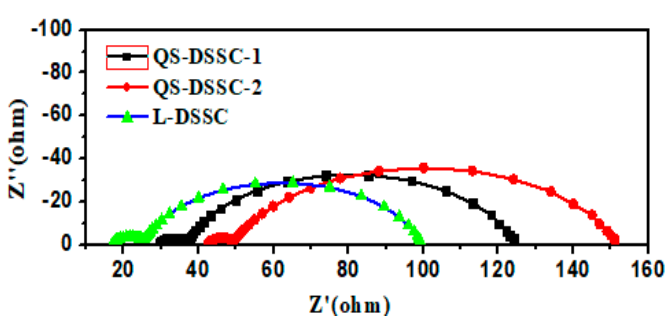
Figure 11. Nyquist plots of the DSSCs with quasi-solid-state electrolytes and ionic liquid